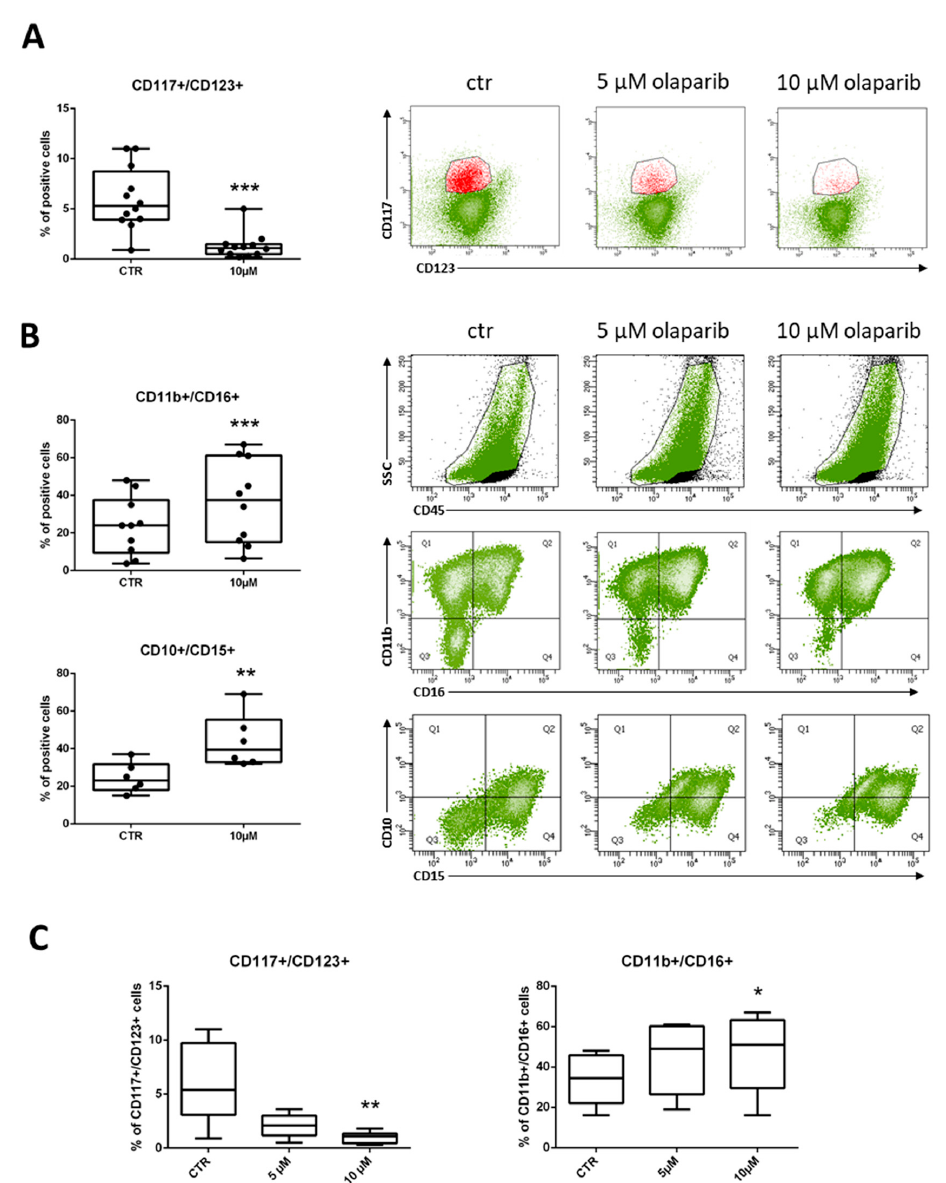
Figure 4. Immunophenotypic analysis of myeloid cells in MDS samples treated with olaparib. ( A ) Flow cytometry analysis of MDS samples treated with olaparib for 7 days vs untreated control cells cultured for the same time period. Box-whisker plots show the proportion of CD117+/CD123+ immature progenitors in MDS samples ( n = 13; paired Wilcoxon test: *** p <0.001). Representative plots show the changes in the expression of CD117+/CD123+ markers (red) in sample ID-76 after treatment with 5 or 10 µM olaparib. ( B ) Box-whisker plots show the proportion of CD11b+/CD16+ ( n = 10) and CD10+/CD15+ ( n = 6) mature neutrophils in MDS samples (paired Wilcoxon test: ** p < 0.01, *** p < 0.001). Representative plots of flow cytometry analysis of CD45+ cells, after lymphocyte (black) exclusion, showing changes in SSC and increased expression of CD11b+/CD16+ or CD10+/CD15+ cells in ID-76 sample after treatment with 5 or 10 µM olaparib. ( C ) Box-whisker plots showing the olaparib dose-dependent effect in CD117+/CD123+ (left panel) and CD11b+/CD16+ (right panel) cells from six samples treated with 5 or 10 µM olaparib. Statistical analysis by Friedman followed by Dunn’s test: * p < 0.05, ** p < 0.01.